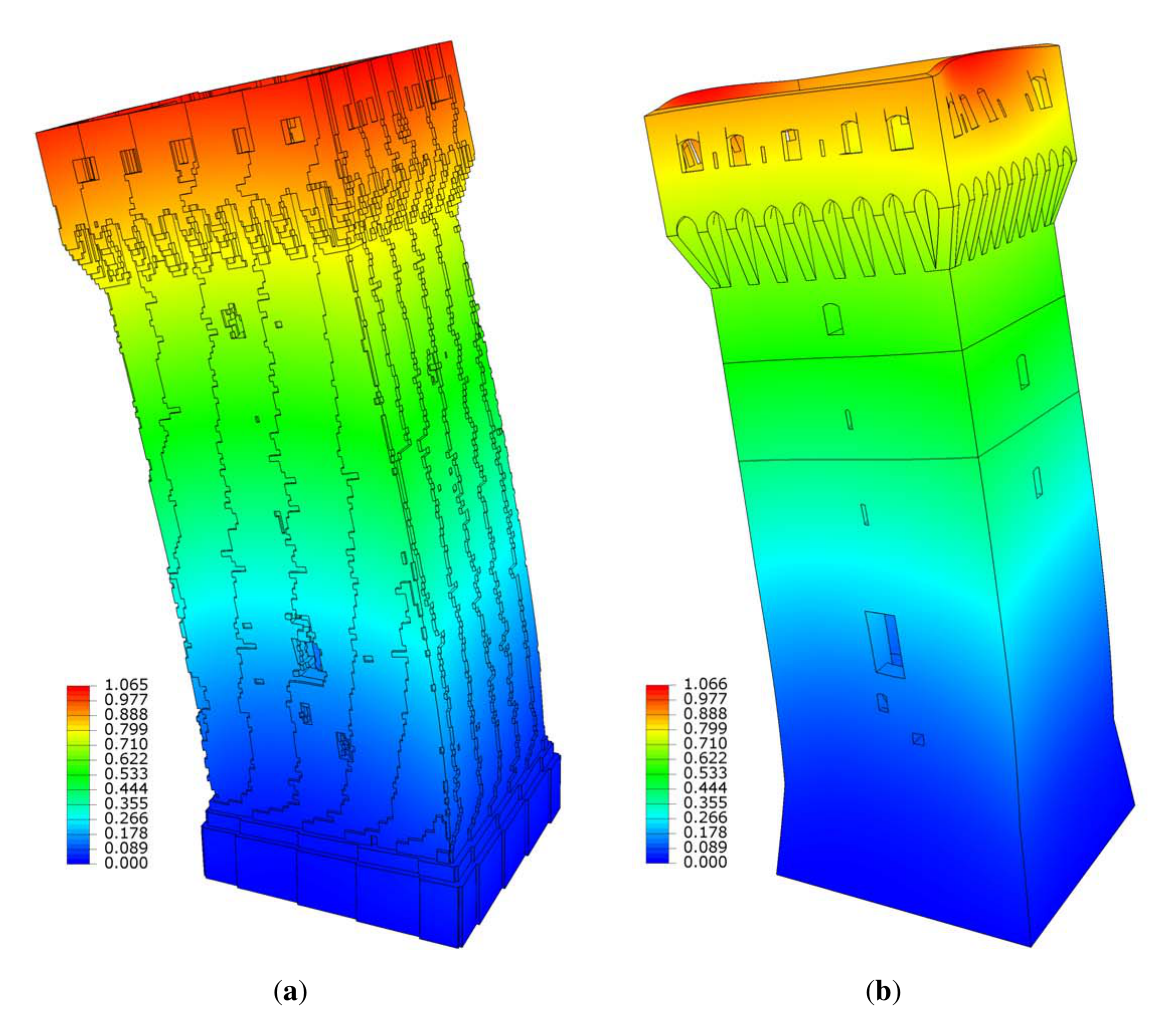
Figure 13. Mode 1: bending mode shape. Displacements magnitude. ( a ) Voxel frequency = 1.9131 Hz; ( b ) CAD frequency = 1.9137